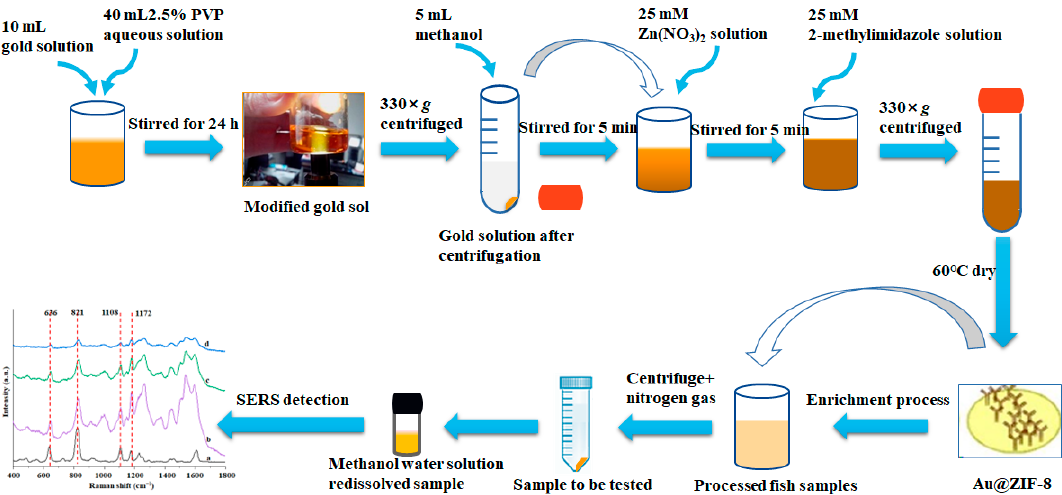
Figure 1. Schematic overview of the experimental program. a. solid BPA standard, b. 3 nm Au@ZIF-8, c. 20 nm Au@ZIF-8, and d. 50 nm